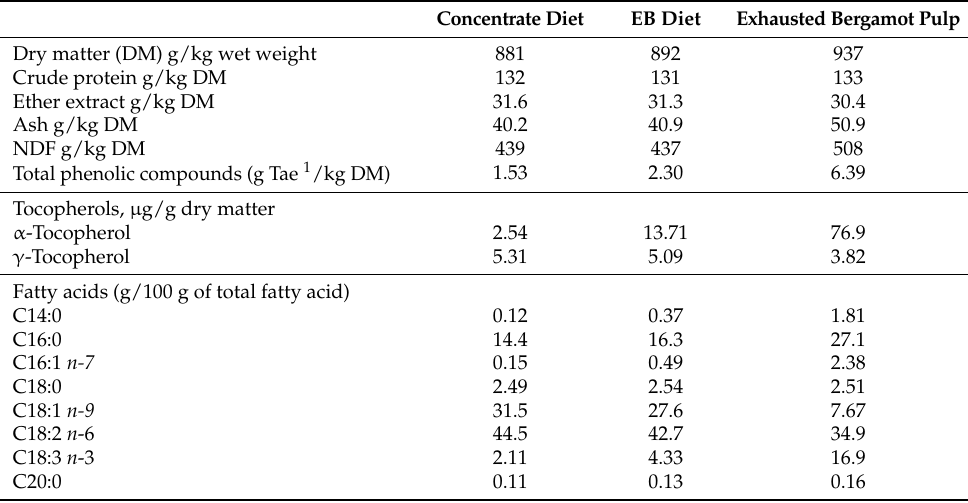
Table 1. Chemical composition of experimental